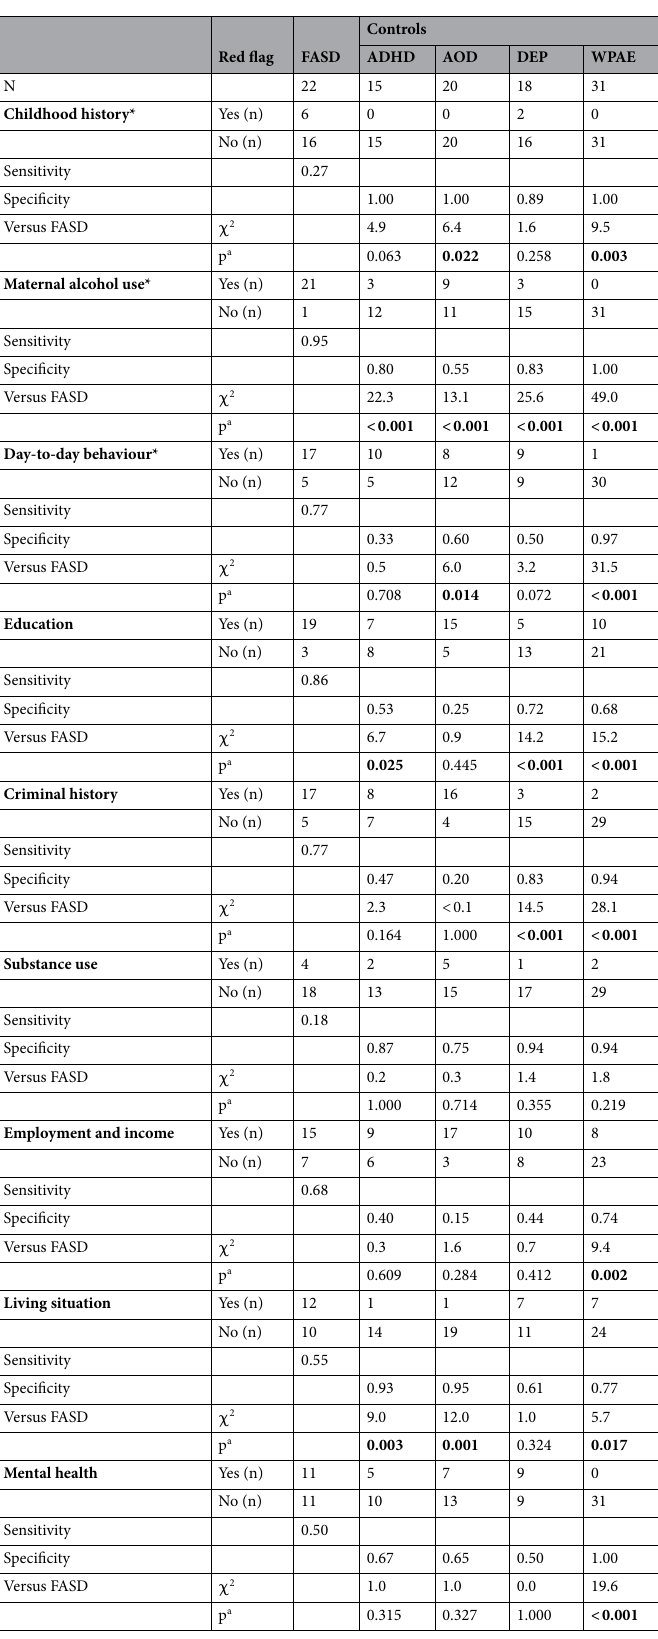
Table 2. BSI-FASD Key Life History Domains (*) and Other Domains in participants with FASD, ADHD, alcohol/opioid dependencies (AOD), depression (DEP), and without prenatal alcohol exposure (WPAE). The table shows absolute frequencies. P values are derived from a χ 2 or Fisher tests. P < 0.05 in